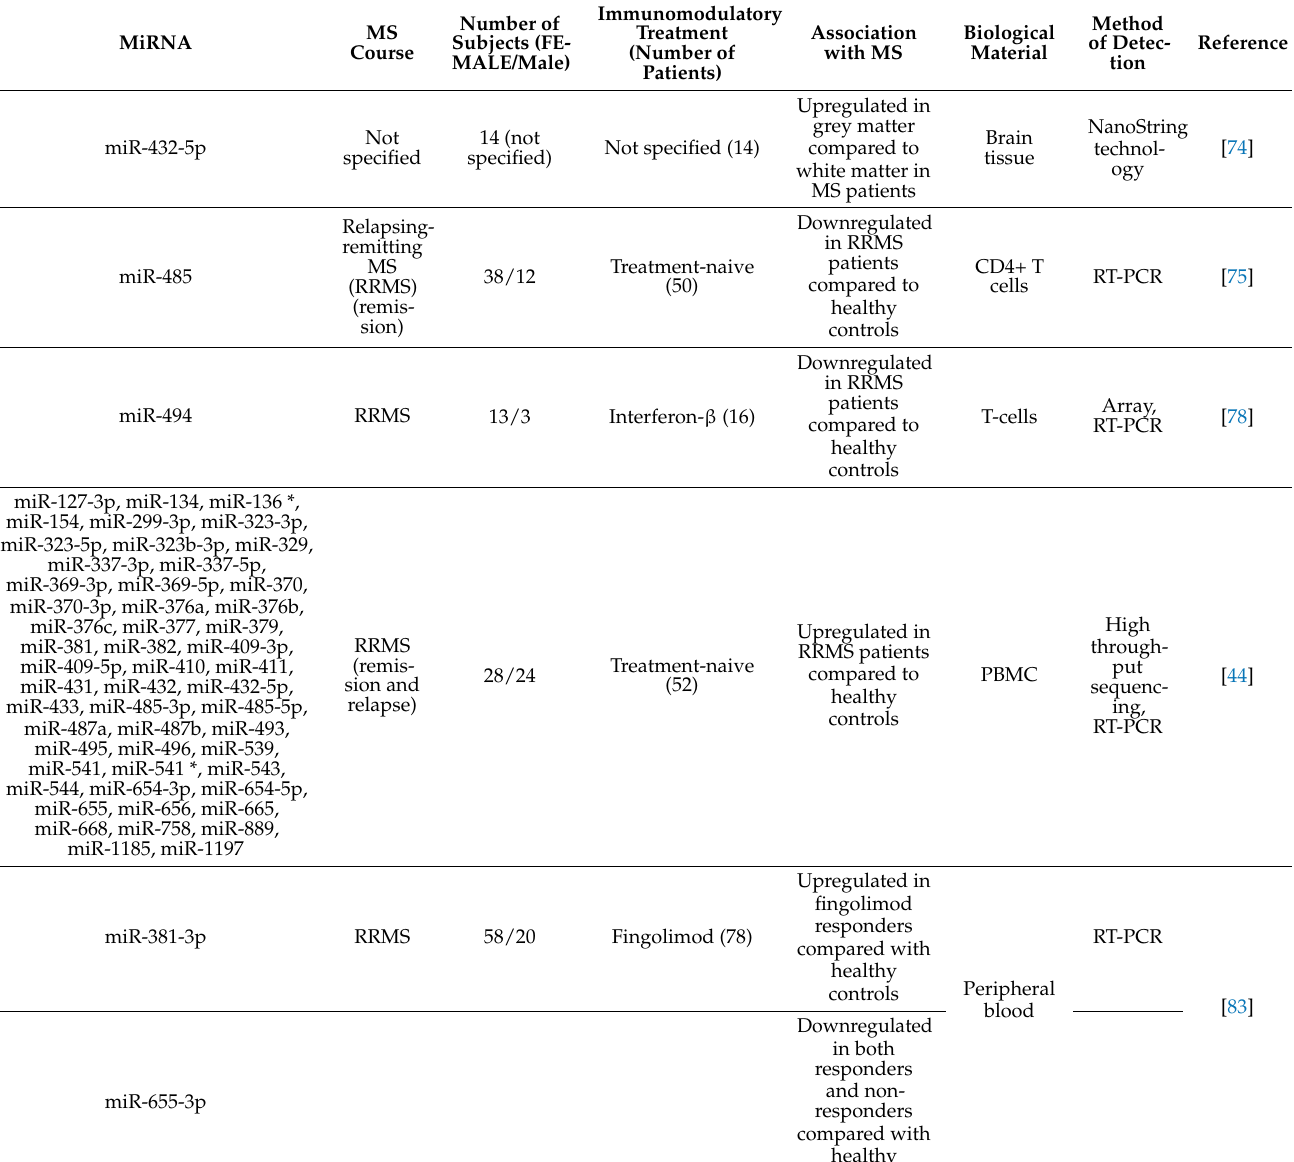
Table 2. MiRNAs from DLK1-DIO3 locus associated with